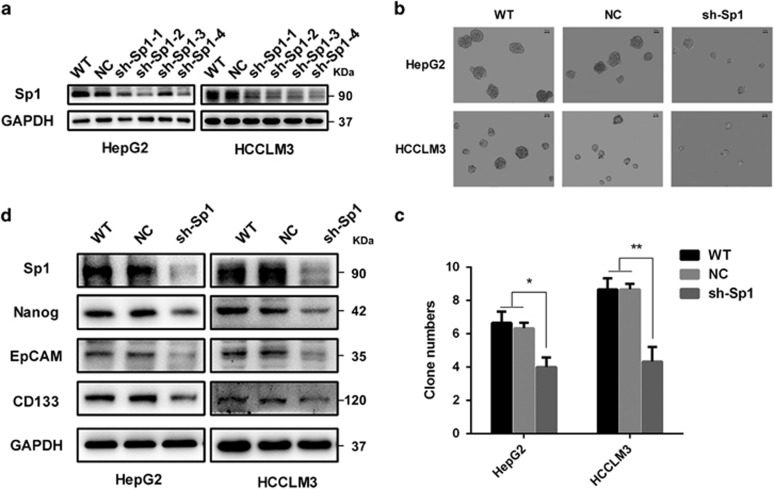
Sp1 suppresses the stemness of HCC in vitro. (a) Western blot analysis to evaluate the expression levels of Sp1 in HepG2, HCCLM3 wild-type (WT), negative control (NC) and Sp1 knockdown (shRNA1, shRNA 2, shRNA 3, shRNA4) cells. (b and c) Representative images and statistical results of HepG2 and HCCLM3 tumor spheres (>50 μm) after indicated treatments (n=3; scale bar: 50 μm). (d) Western blot analysis of Nanog, EpCAM, CD133 in HepG2, HCCLM3 wild-type (WT), negative control (NC) and Sp1 knockdown (shRNA4) cells. Statistical analysis by paired t-test (*P<0.05, **P<0.01)